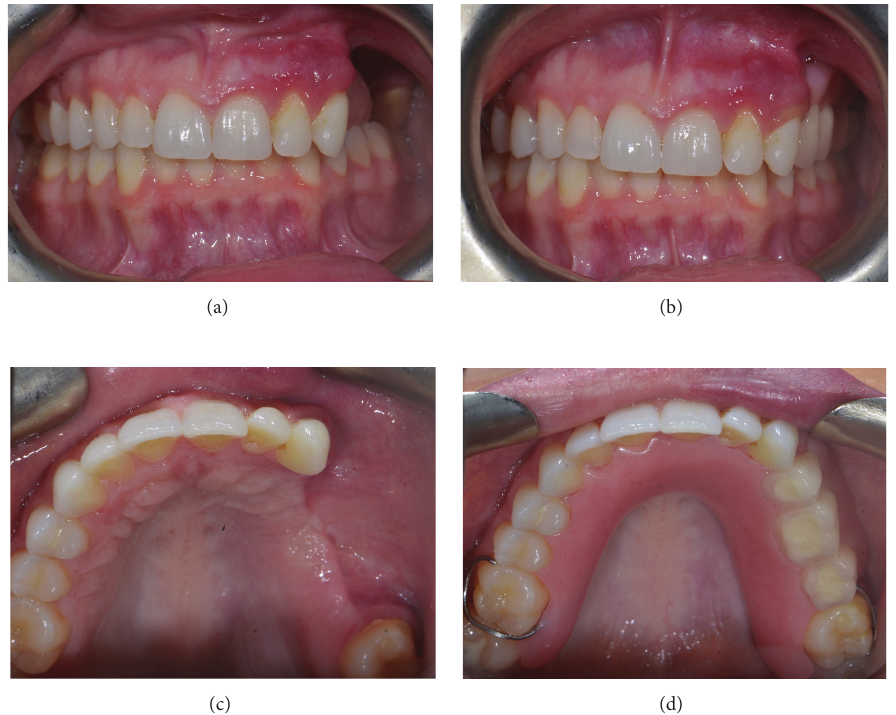
Figure 7: Intraoral frontal ((a), (b)) and occlusal ((c), (d)) views without ((a), (c)) and with ((b), (d)) dental prosthesis. At 11 months after excision of recurrence, there is no evidence of disease. Hypervascular markings persist in the left anterior maxillary vestibule. The removable prosthesis provides esthetic and functional benefits while permitting hygiene and surveillance for